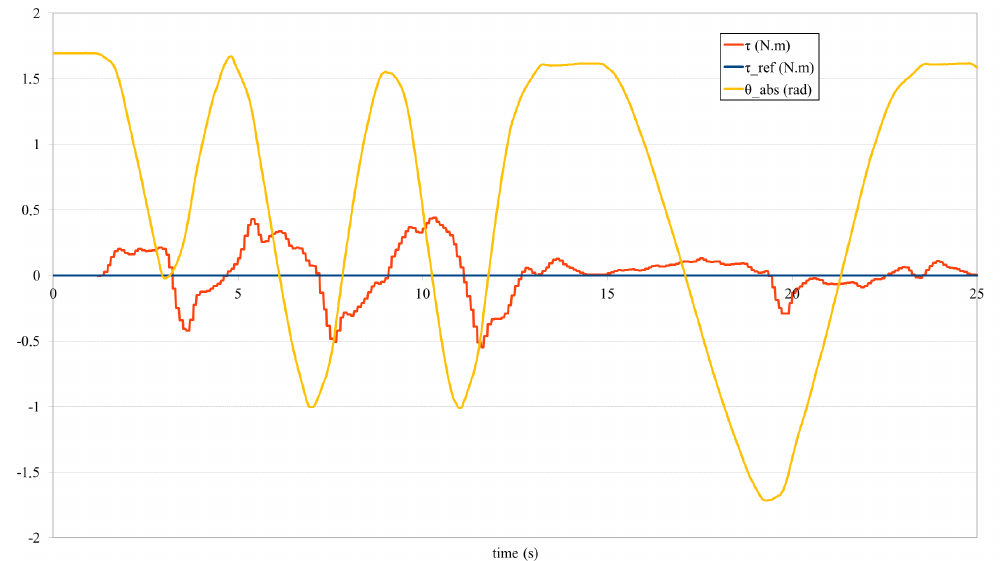
Figure 13. Response to changes in the position, maintaining force reference.